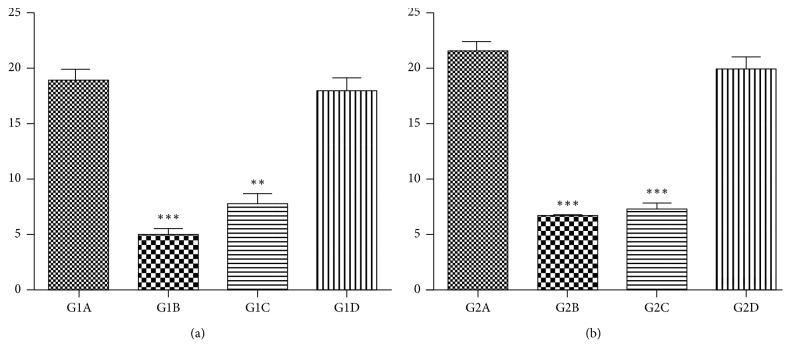
Statistical evaluation of 3βHSD-positive Leydig cell numbers in testicular tissue sections of Group 1 (a) and Group 2 (b) subjects. ∗∗∗p < 0.0001; ∗∗p < 0.001; ∗p < 0.01.